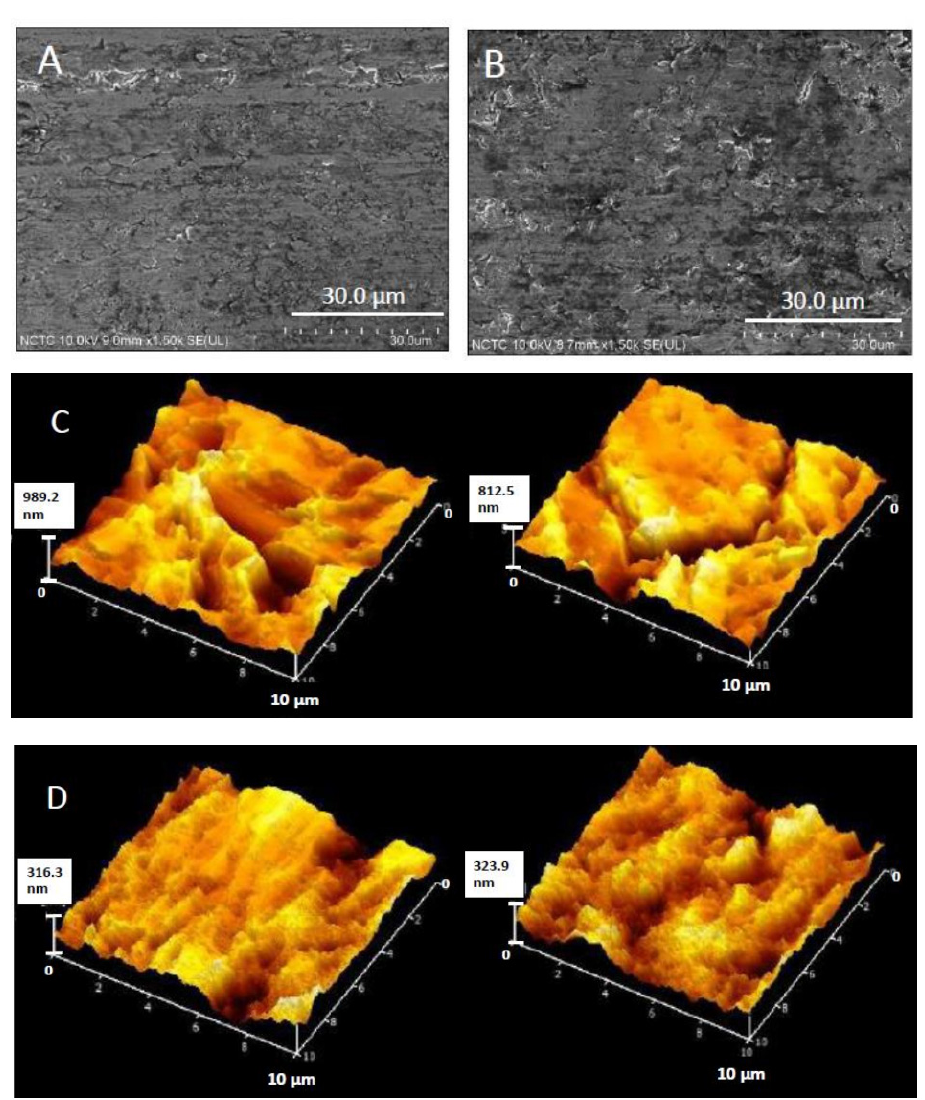
Figure 5. Surface morphology of titanium substrate before ( A ) and after ( B ) being treated with the cathodically electrical polarization; surficial roughness before ( C ) and after ( D ) being treated with the cathodically electrical polarization .